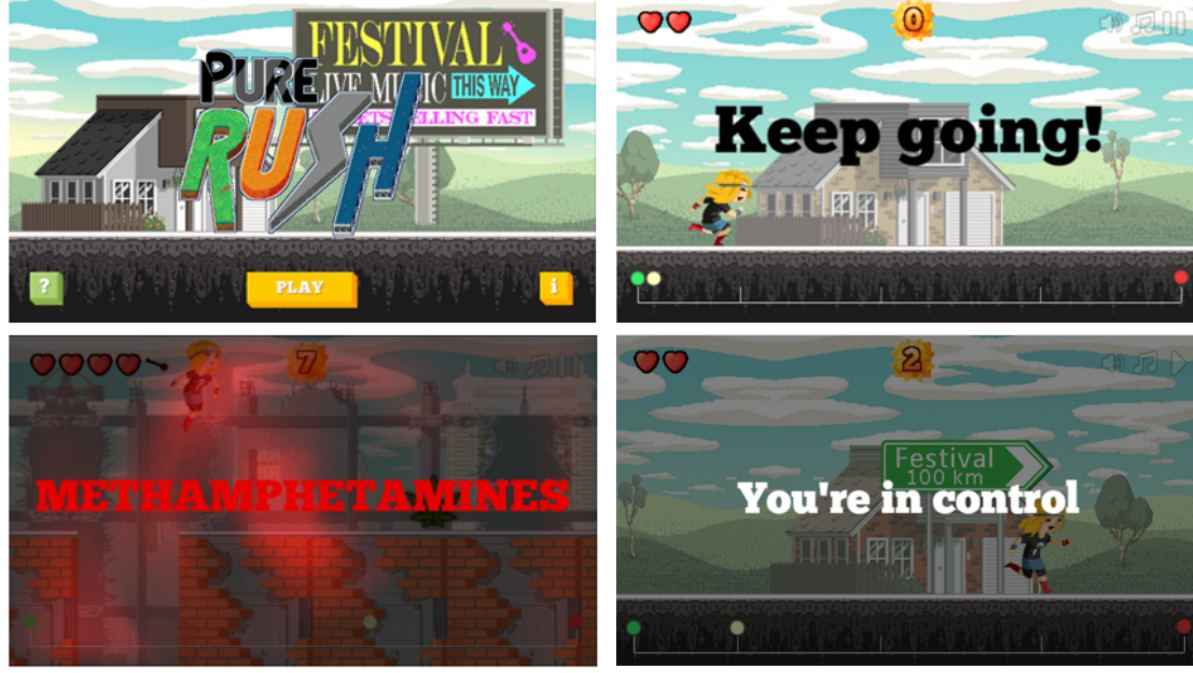
Figure 4. Screenshots of the Pure Rush app. (Source: Pure Rush Android App Version 2. Developers: National Health and Medical Research Council Centre of Research Excellence in Mental Health and Substance Use and 2and2. Licensed under fair